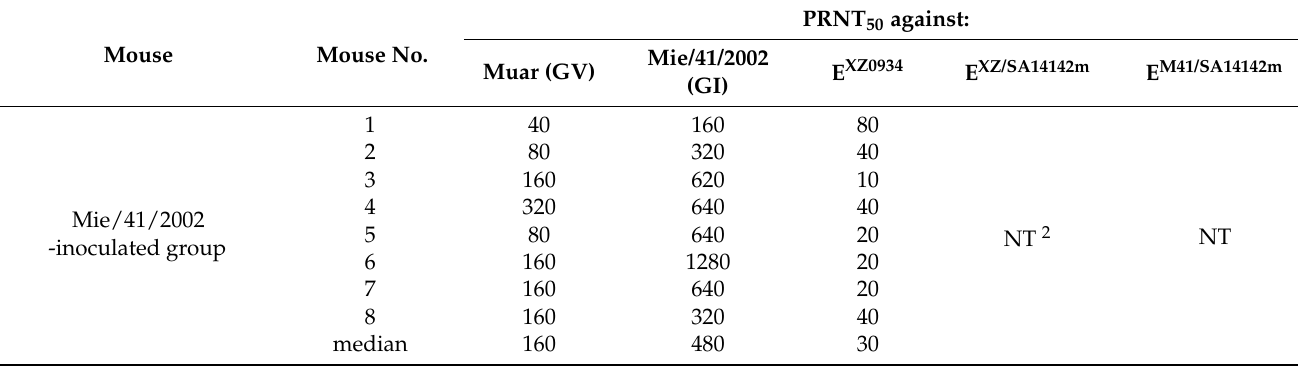
Figure 4. Neutralization activity of serum taken from mice inoculated with recombinant JEV strains. Sera were collected from surviving mice inoculated with Mie/41/2002 ( n = 8), E M41/SA14142m (E_M41/SA14142m, n = 10), E XZ0934 (E_XZ0934, n = 3), or E XZ/SA14142m (E_XZ/SA14142m, n = 10) and mice mock-inoculated ( n = 10) as shown in Figure 3A, and used for measuring PRNT 50 against JEV Muar ( A ) and Mie/41/2002 ( B ) strains. Dotted line: detection limit. Significance was analyzed using the Kruskal-Wallis test (* p < 0.05, ** p < 0.01, *** p < 0.001); NS: not statistically significant. Table 1. Neutralization titers (PRNT 50 ) of sera from mice infected with recombinant JEVs against GI, GV, and recombinant JEVs 1 .